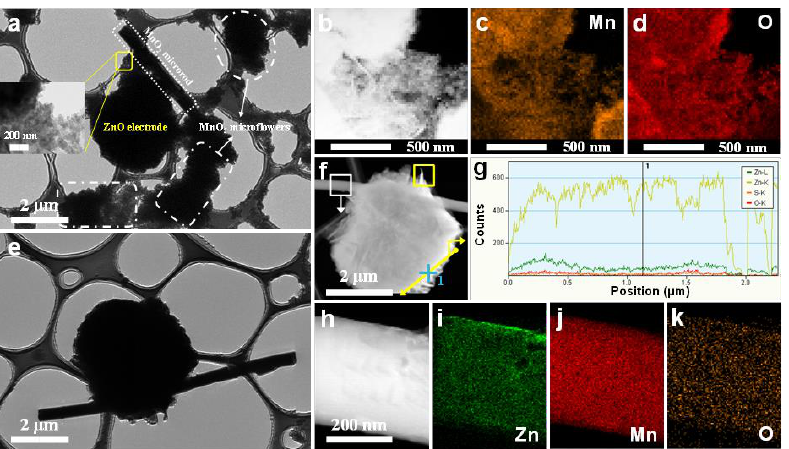
Figure 4. Ex situ TEM image of ZnO microspheres at 100 mA g −1 current density in ZMS electrolyte; ( a ) low-resolution image after 1st charge and high-resolution TEM image of the in-situ-formed microflowers (inset of a); ( b – d ) elemental mapping of the in-situ-formed microflowers in the charging process; ( e ) low-resolution image after 1st discharge, ( f ) brightfield image of the ZnO microspheres with the corresponding ( g ) elemental line profile of the nanoflakes on the ZnO microspheres Zn, S, and O; and ( h – k ) elemental mapping of the microrod after 1st discharge